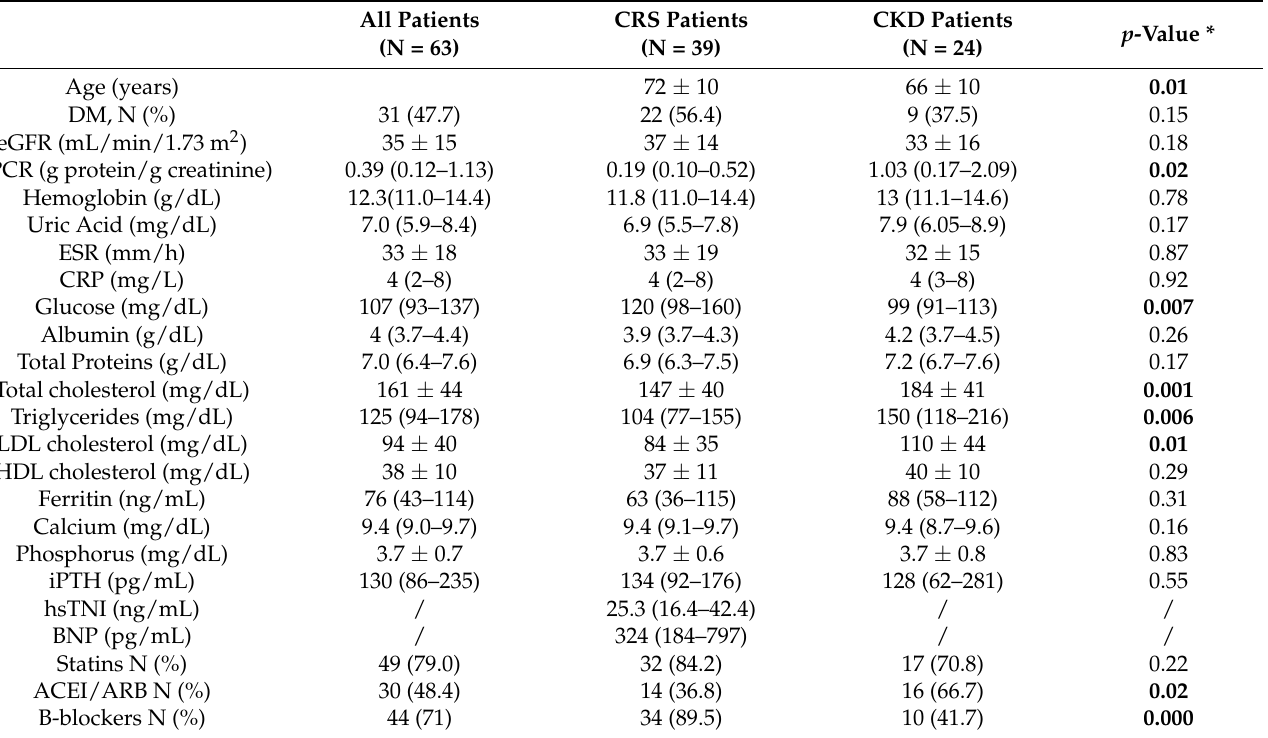
Table 1. Main clinical characteristics in all patients, in patients with type 2 CRS, and in CKD patients. Statistically significant differences between subgroups are highlighted in